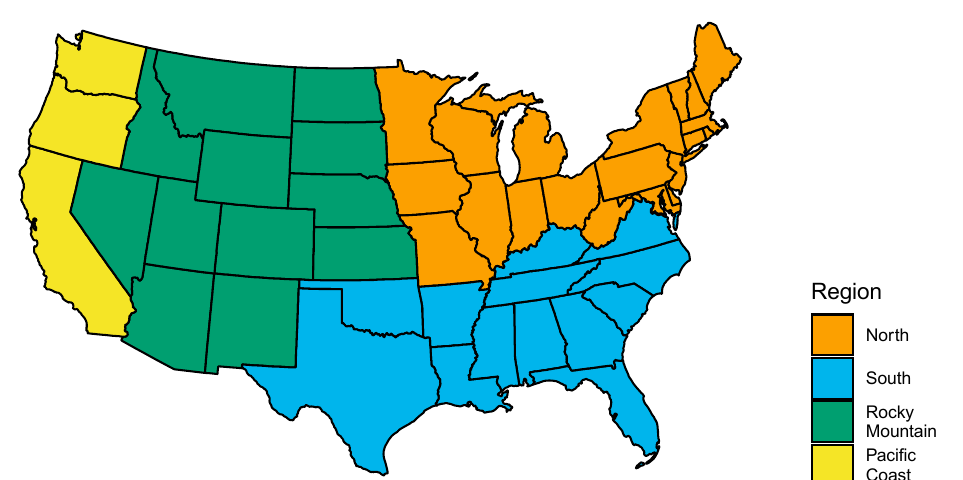
Figure 1. Regions used to analyze Montréal Process Criteria and Indicators across forest ownership categories of the conterminous USA.